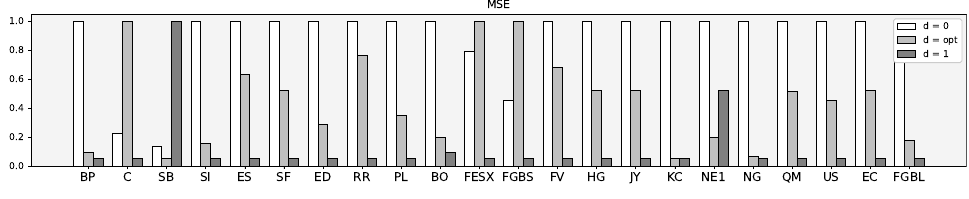
Figure 7. MSE scaled between 0 and 1. Forecasting prices with LSTM. Strategies returns